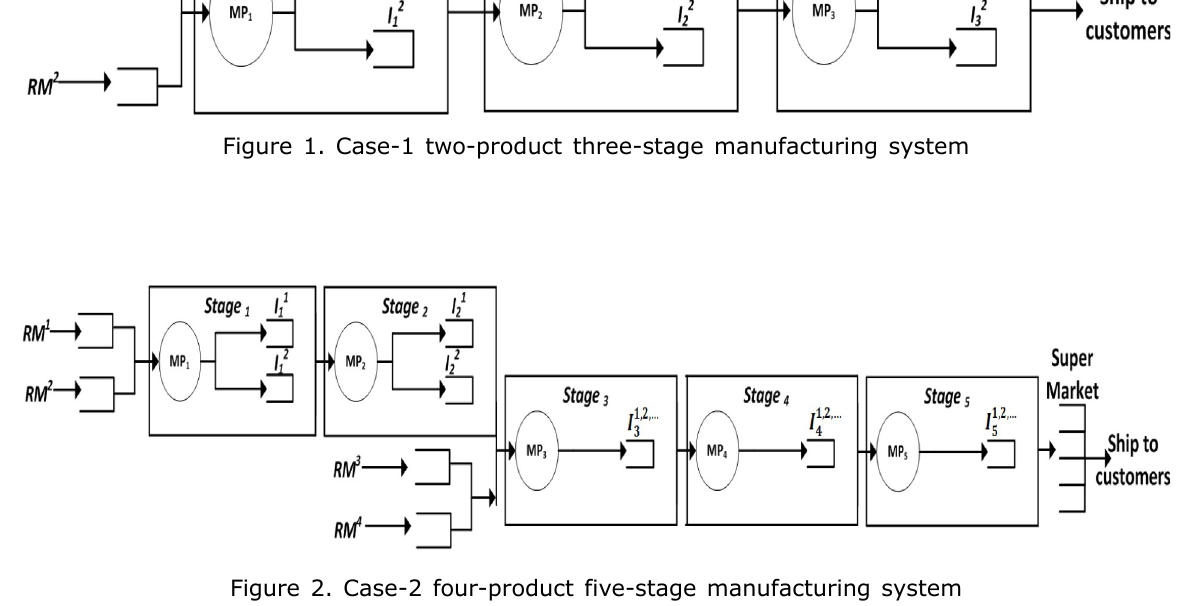
Figure 2. Case-2 four-product five-stage manufacturing system